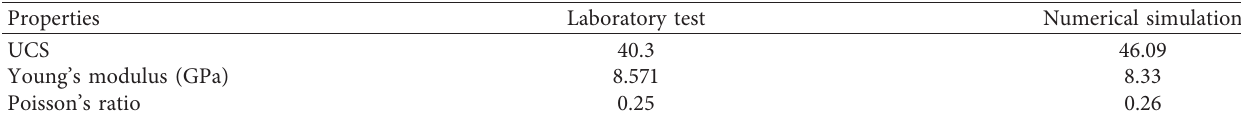
Table 4: Comparison between the experimental result reported by Moosavi [23] and calculated from numerical simulation.